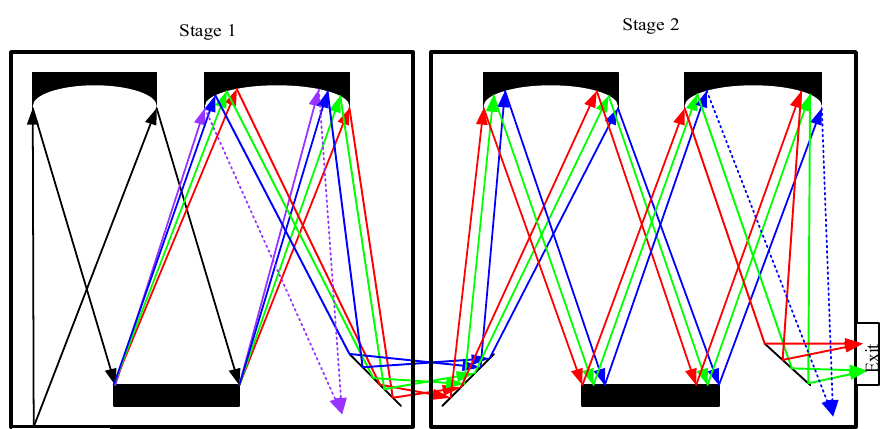
Figure 3. Simplified diagram of an additive double